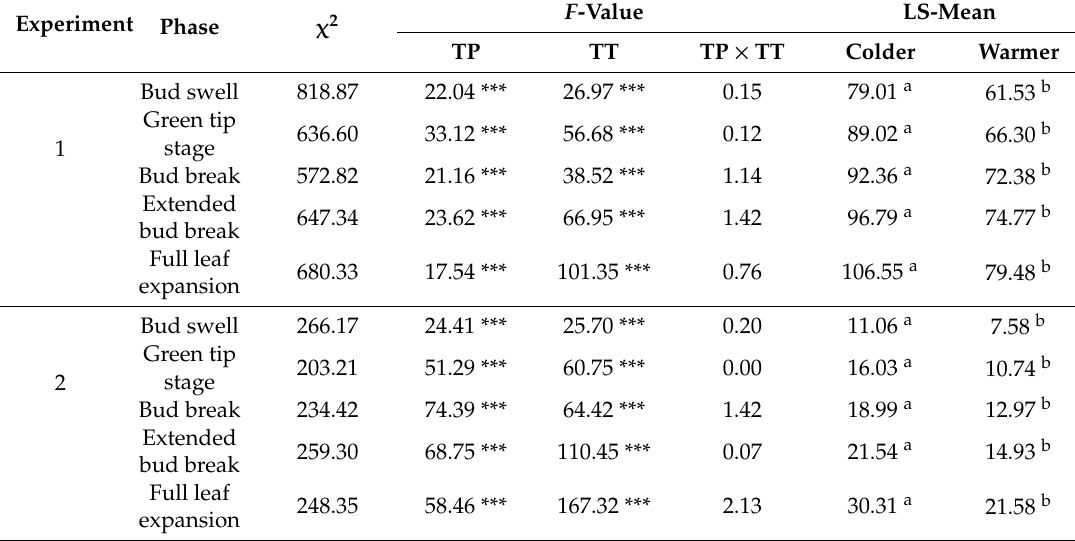
Table 3. Linear mixed model (LMM) comparisons of the timing of each bud break phase (days from the beginning of the experiment) in sugar maple resulting from the two experiments using mean annual temperature at the origin site (TP), thermal treatment in growth chamber (TT), and their interaction as e ff ects, as well as the least-squares mean (LS-mean) when a given phenological phase was observed at day / night temperatures of 14 / 10 (Colder) and 18 / 14 ◦ C (Warmer), respectively. Three asterisks indicate p < 0.001. LS-Mean values bearing di ff erent letters within rows are statistically di ff erent at 0.05